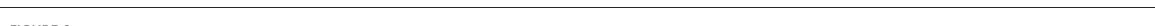
FIGURE6 yellow for H3 cluster, purple for H4 cluster, green for H5 cluster, and cyan for H6 cluster. The same color code is used for the other panels. The lines below correspond to the type of neurons with Shox2 + neurons in black and Chx10 + neurons in red. (Bi) Incidence of the six H clusters in all 171 Shox2 neurons (solid) and Chx10 neurons (hatched). H1 cluster ( n = 15), H2 cluster ( n = 20), H3 cluster ( n = 32), H4 cluster ( n = 25), H5 cluster ( n = 27) and H6 cluster ( n = 52). (Bii) Incidence of the H clusters observed in 143 Shox2 neurons (left): H1 ( n = 15), H2 ( n = 20), H3 ( n = 24), H4 ( n = 20), H5 ( n = 25) and H6 cluster ( n = 39). Incidence of the H clusters observed in 28 Chx10 neurons (right): H1 and H2 ( n = 0), H3 ( n = 8), H4 ( n = 5), H5 ( n = 2) and H6 cluster ( n = 13). (C) Three-dimensional representation of all neurons (Shox2 filled, Chx10 open) on the three principal components (same as Figure 2B but a different angle). Ellipsoids are centered on the mean for the three first PCs and semi-axes are generated by the standard deviation of each three first PC. (D) Plot of the cluster silhouettes values. (E ) Comparisons of electrophysiological properties of the neurons from H1, H2, H3, H4, H5 and H6 clusters. Filled circles and error bars represent the mean and standard deviation, open gray circles represent individual neurons. * p < 0.05, one-way ANOVA with Tukey post-hoc test or Kruskal-Wallis with Dunn’s post-hoc test. * significantly different from the corresponding color coded